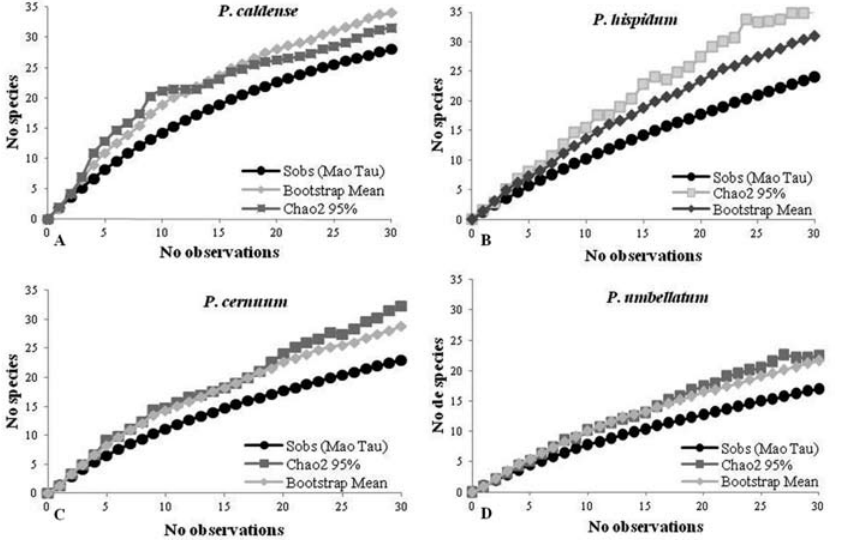
Fig. 2. Rarefaction curves for the plants studied in the Serra Bonita RPPN, Bahia, Brazil. September 2010-May 2011: A) P. caldense , B) P. hispidum , C) P. cernuum , D) P. umbellatum